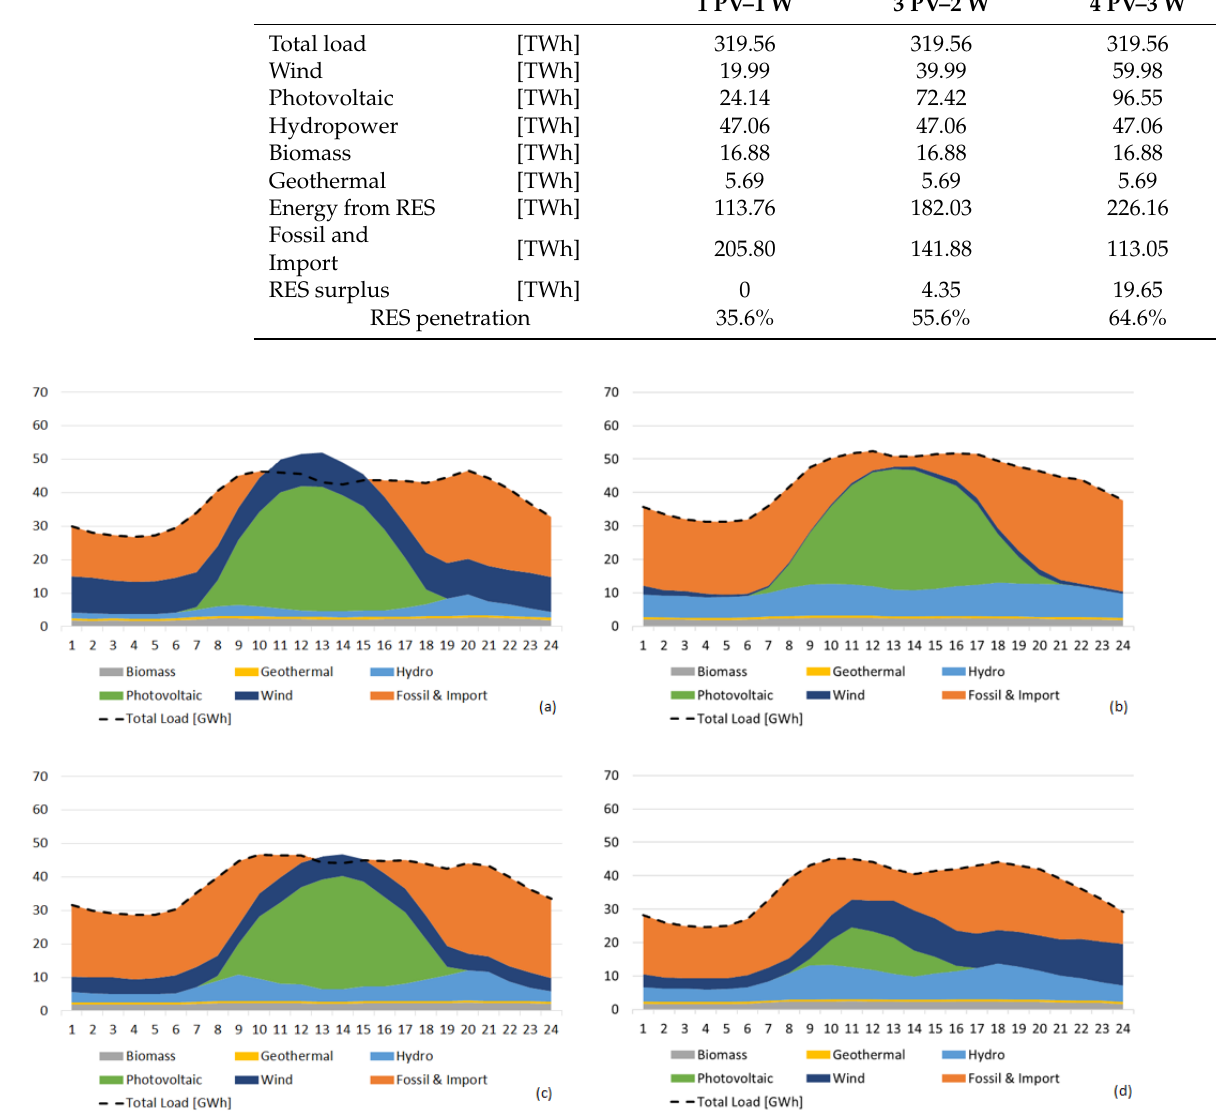
Figure 4. Case 1 with thrice the production from photovoltaic and twice the production from wind. Energy mix for the electric energy supply on ( a ) 21 March, ( b ) 21 June, ( c ) 20 September and ( d ) 20 December 2019.